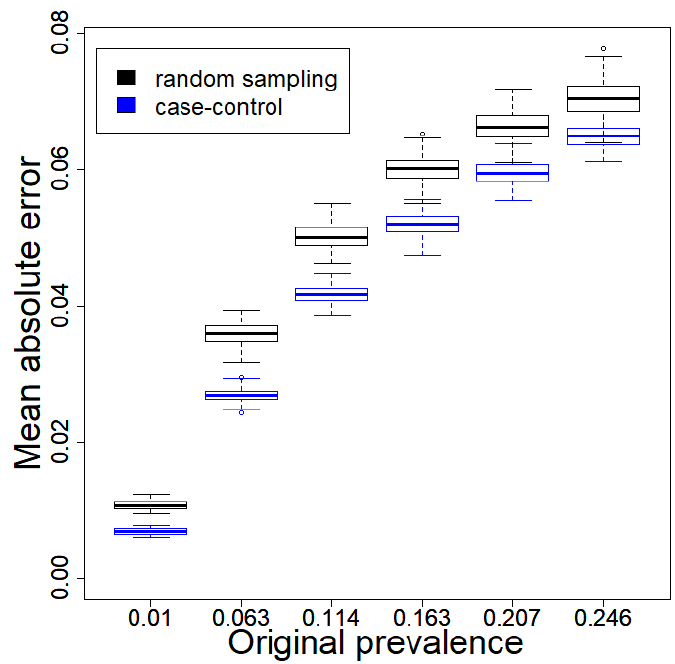
Figure 5. The random forest model trained with case-control (CC) data and using adjusted probabilities yields better probability estimates when compared to the same model trained with randomly sampled (RS) data. Data with an increasing prevalence of cases were generated by systematically varying σ 2 from 0.1 to 2.6. The mean absolute error was calculated by comparing the estimated probabilities to the true probabilities and lower values indicate better performance. The displayed results are based on 100 simulated datasets for each value of σ 2 .